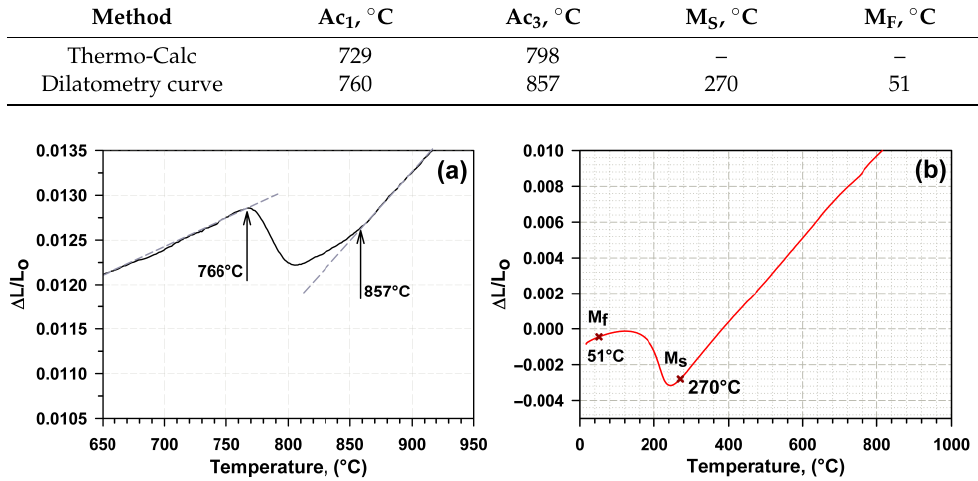
Figure 2. Dilatation curves obtained during heating ( a ) and cooling ( b